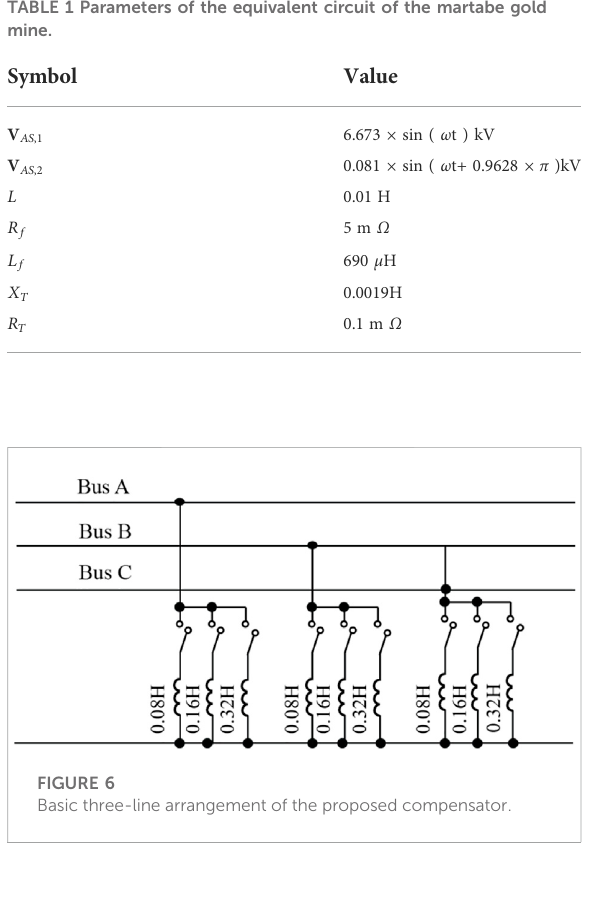
FIGURE 5 Single-line electric diagram of a compensated system using VSC.